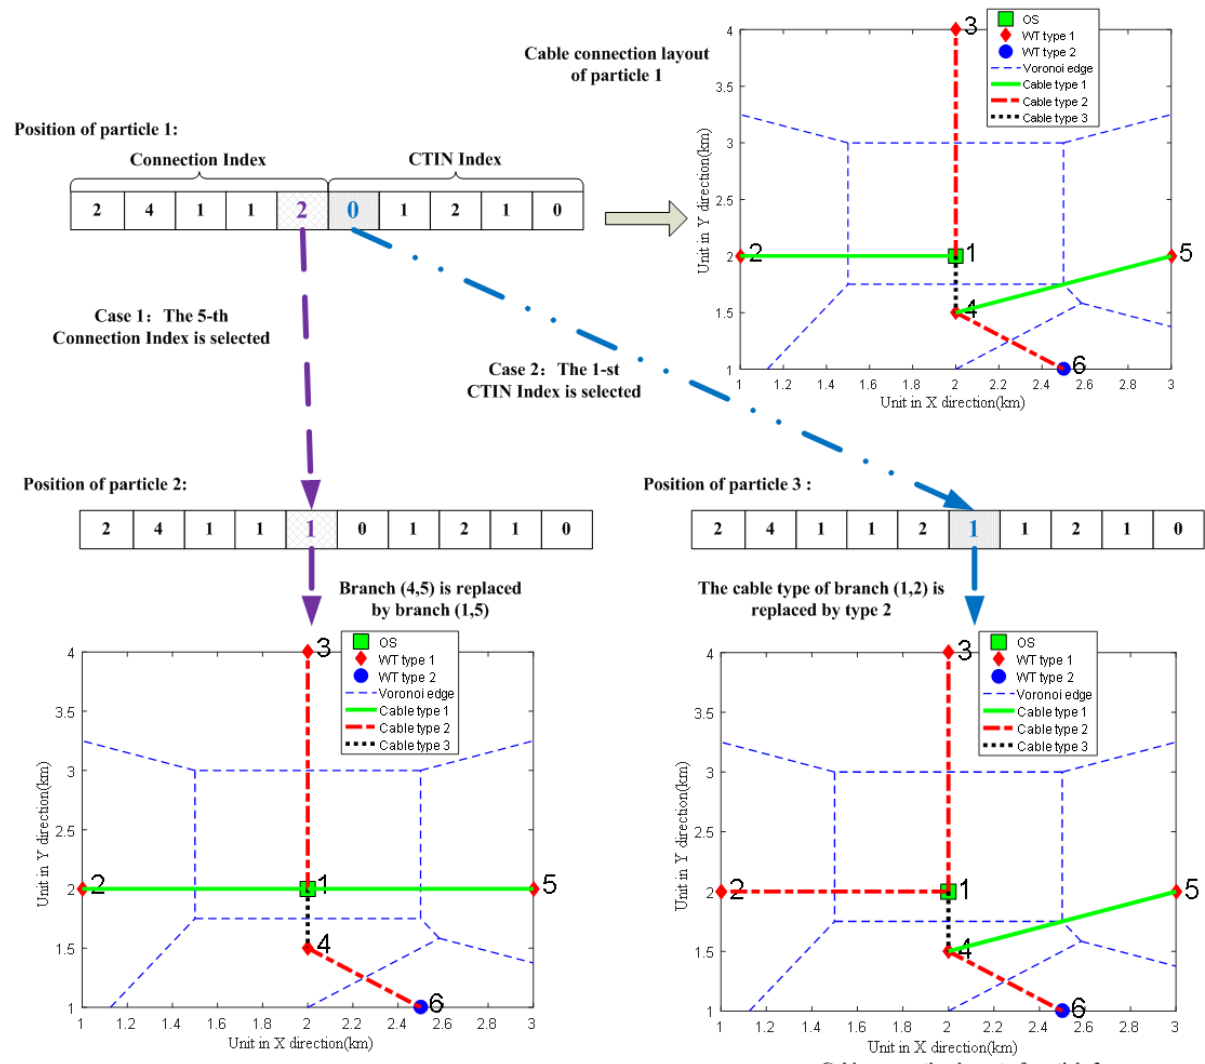
Figure 7. LSS for OWFD.